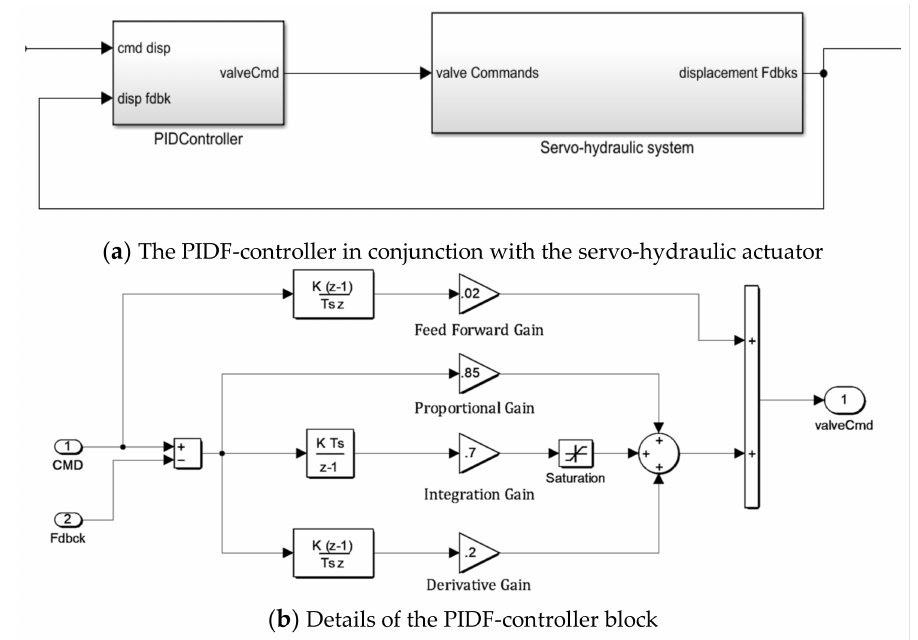
Figure 6. Proportional-Integral-Derivative-Feed-forward (PIDF)-controller in conjunction with the servo-hydraulic actuator and the